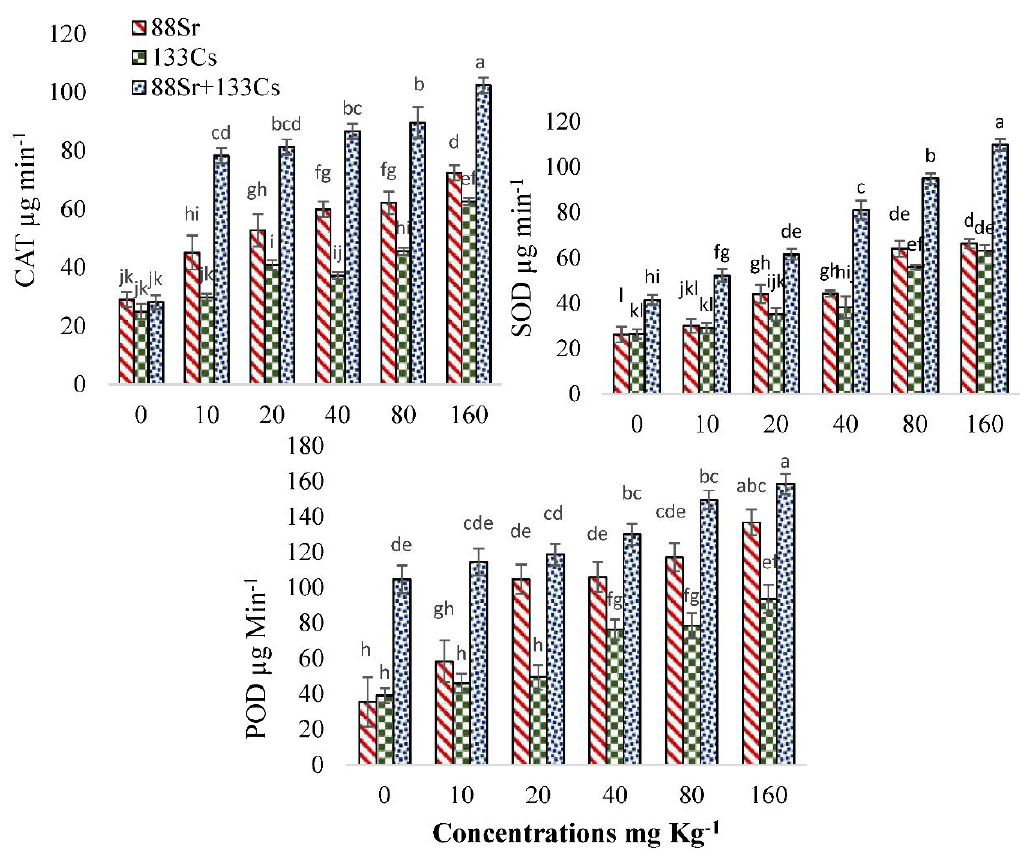
Figure 3. The effect of 88 Sr, 133 Cs, and 88 Sr + 133 Cs stress on the activity of antioxidant enzymes of CAT, POD, and SOD of cucumber to various concentrations (0 to 160 mg kg −1 ) of 88 Sr, 133 Cs, and 88 Sr + 133 Cs treatments. The columns sharing different letters are significantly different at p < 0.05. The error bars indicate standard deviation.